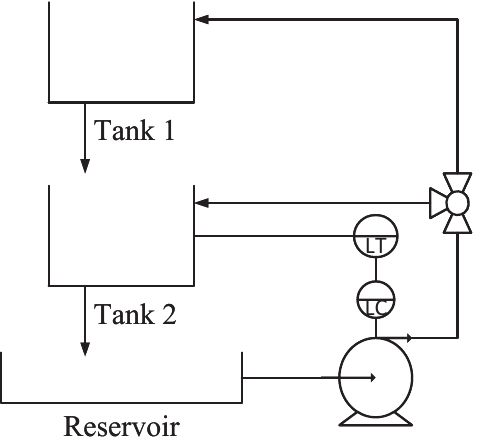
Figure 2. MIMO level control on a dual tank system. Adapted from